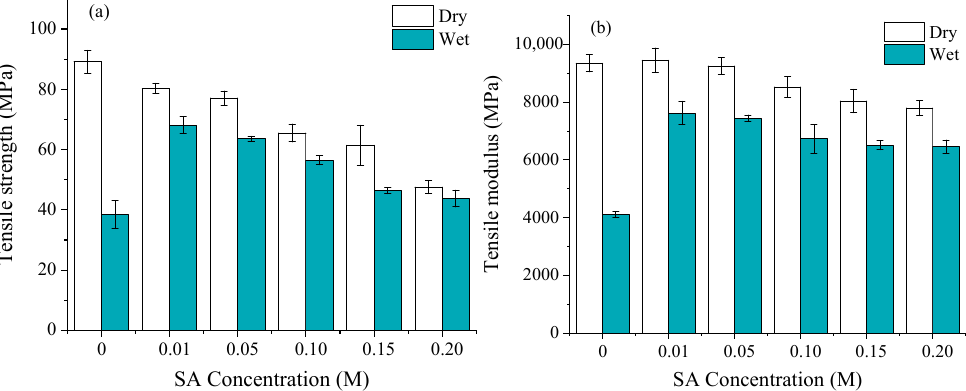
Figure 9. The effect of SA concentration on ( a ) tensile strength and ( b ) tensile modulus of NP/HDPE composite in dry and wet conditions.